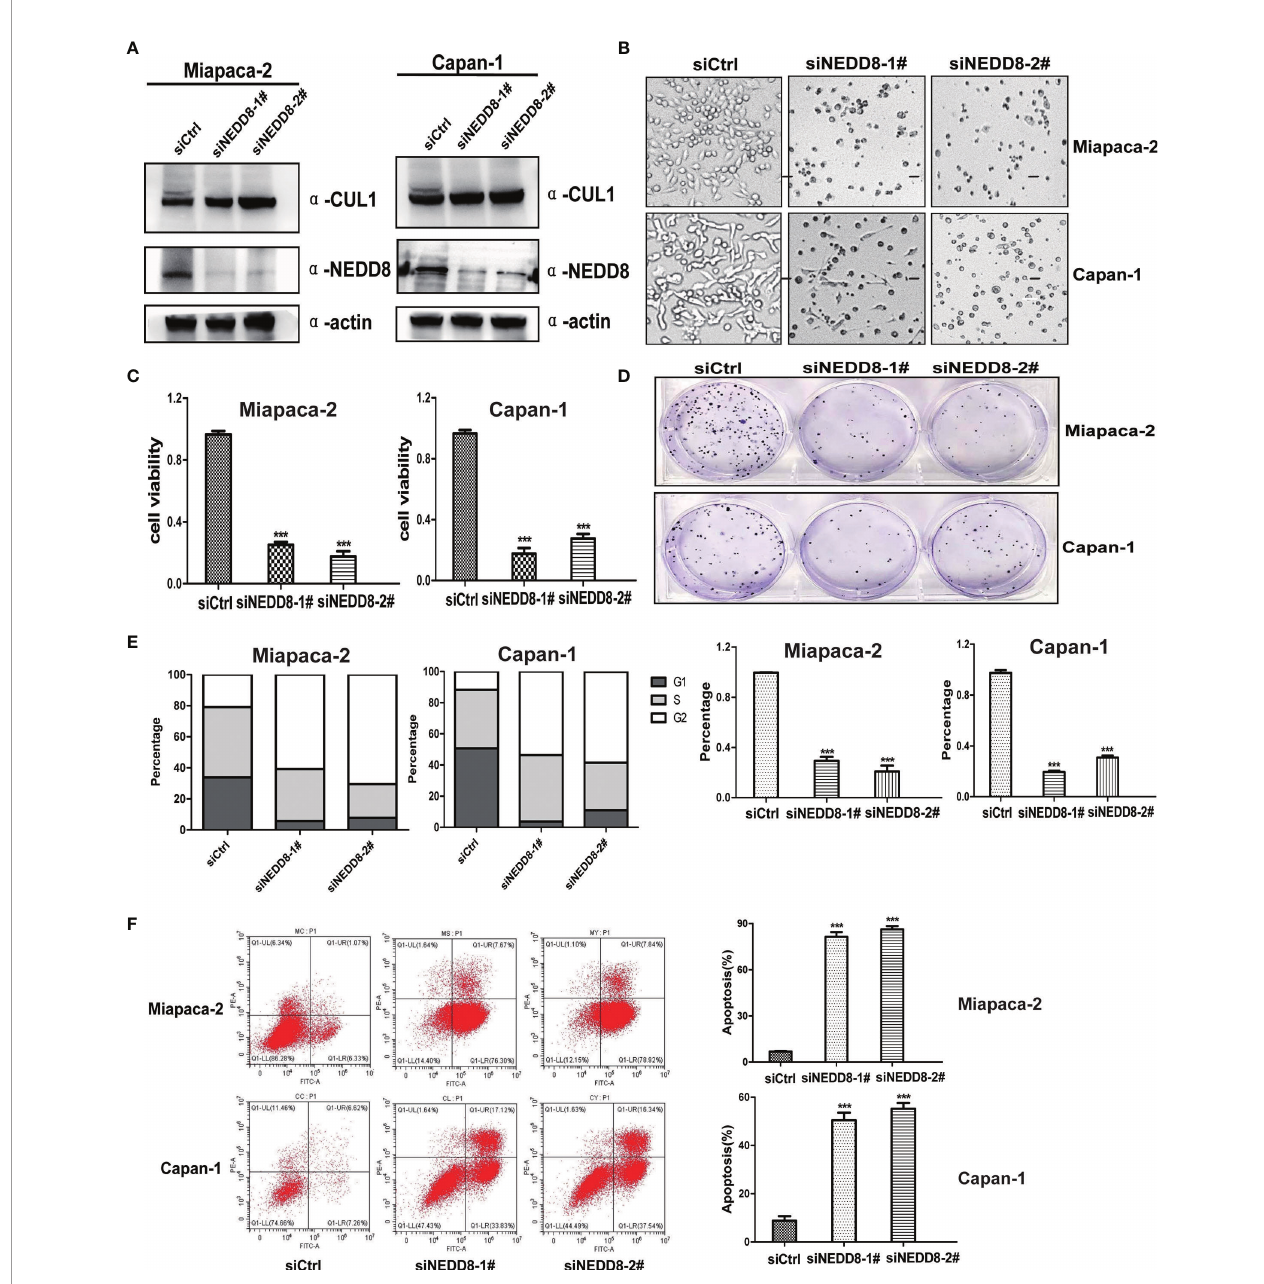
FIGURE 3 | Depletion of the neddylation pathway suppressed the malignant phenotypes of pancreatic cancer cells in vitro . (A) siNEDD8 impaired Cullin neddylation. Miapaca-2 and Capan-1 cells were transfected with siControl and two siNEDD8 for 72 h and subjected to immunoblotting using antibodies against Cullin 1 and NEDD8 with actin as a loading control. (B) Growth suppression of pancreatic cancer cells by siNEDD8. Miapaca-2 and Capan-1 cells were transfected with siControl, siNEDD8-1#, and siNEDD8-2# for 72 h and subjected to the micrograph. Scale bar = 200 m m. (C) siNEDD8 inhibited pancreatic cancer cell proliferation. Miapaca-2 and Capan-1 cells were transfected by siControl, siNEDD8-1#, and siNEDD8-2#. After 24 h, 2,500 cells were seeded in 96-well plates in triplicates and then subjected for Cell Counting Kit-8 (CCK8) assay (mean ± SD, ***p < 0.001, n = 3). (D) siNEDD8 suppressed colony formation in pancreatic cancer cells. Miapaca-2 and Capan-1 cells were transfected by siControl, siNEDD8-1#, and siNEDD8-2#. After 24 h, 150 cells were seeded into 6-well plates for 10 days, followed by crystal violet staining and colony counting (mean ± SD, ***p < 0.001, n = 3). (E) siNEDD8 induced G2-M cell cycle defects. Miapaca-2 and Capan-1 cells were transfected with siControl, siNEDD8-1#, and siNEDD8-2# for 72 h, followed by propidium iodide (PI) staining and fl uorescence-activated cell sorting (FACS) analysis for cell cycle pro fi le. (F) siNEDD8 induced apoptosis in a dose-dependent manner. Miapaca-2 and Capan-1 cells were transfected with siControl, siNEDD8- 1#, and siNEDD8-2# for 72 h and subjected to Annexin V-FITC/PI double-staining analysis. (mean ± SD, ***p < 0.001, n = 3). These data were representative results of three independent experiments with similar trends. Data represent means, and error bars are SD. Two-sided